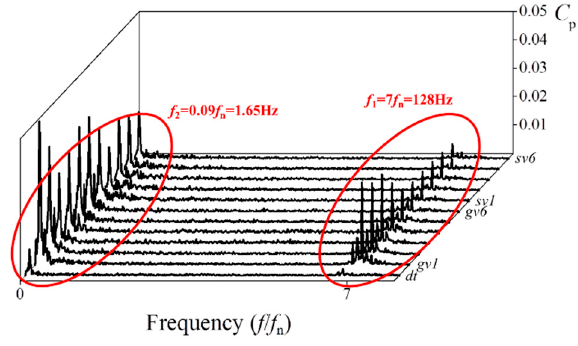
Figure 12. FFT results of pressure fluctuations at condition V. Table 3. Cross-phase delays between several couples of monitoring points at condition V. Couple of Monitoring Points Cross-phase delay of 1.65